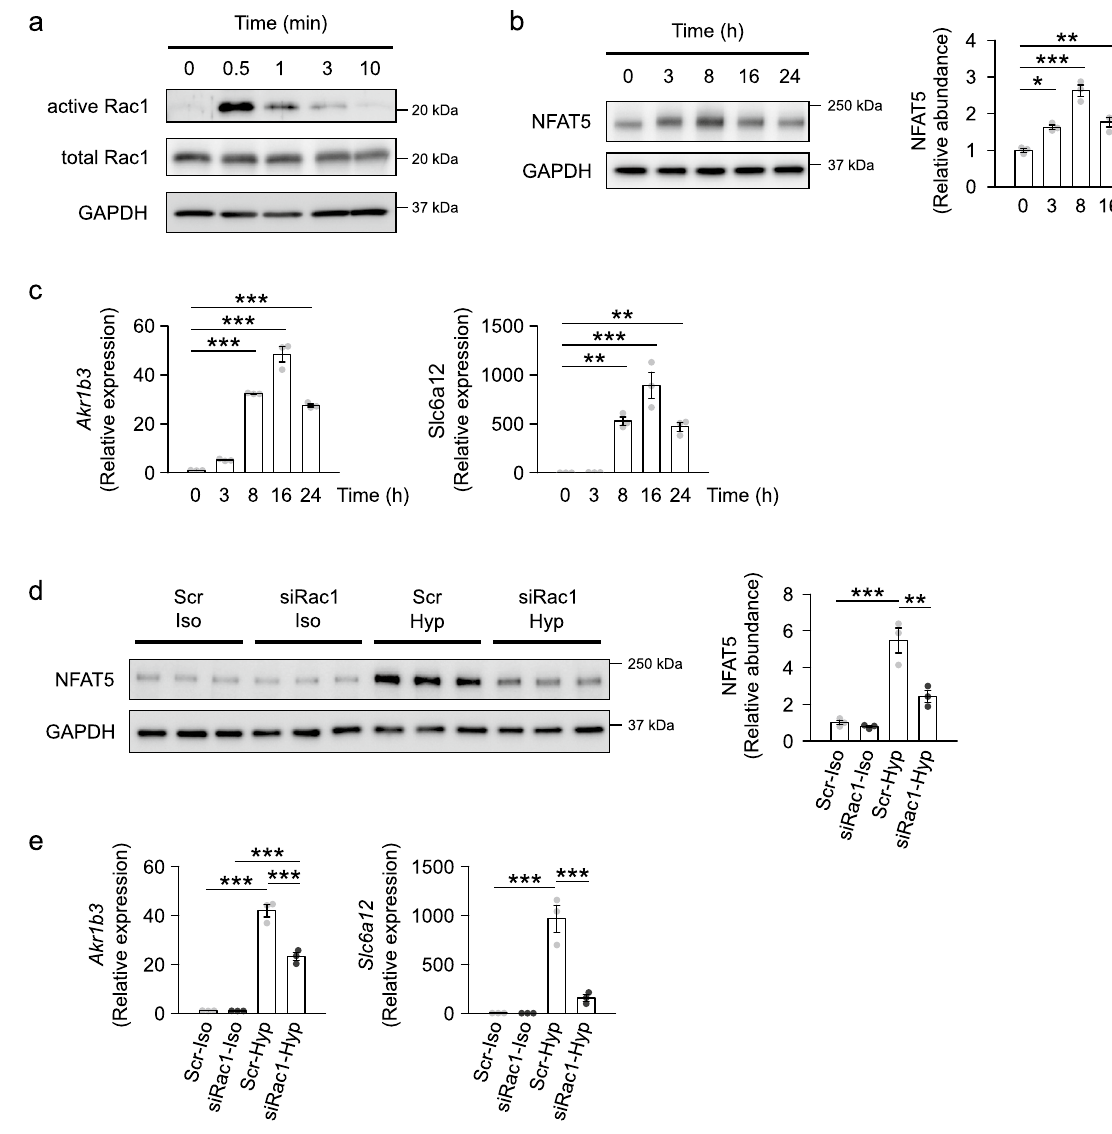
Figure 5. Rac1 deficiency impairs NFAT5-mediated osmoprotective signaling in mIMCD3 cells. ( a ) Hyperosmotic stress induces activation of Rac1 in mIMCD3 cells. mIMCD3 cells were cultured in